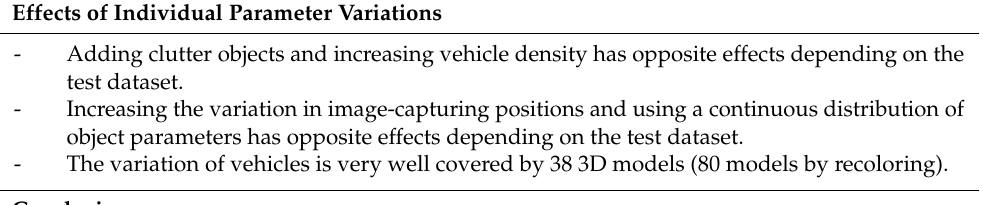
Table 5. Influences of different parameter variations in training data